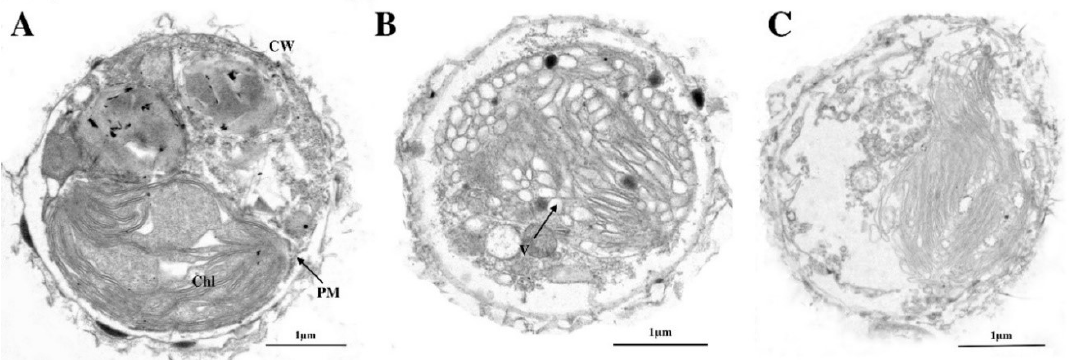
Figure 2. Ultrastructure of P. globosa after treatment with 8 g/L of E. acoroides aqueous extract. ( A ) Control, ( B ) 48 h, ( C ) 96 h. Chl, chloroplast; PM, plasma membrane; V, vacuole; CW, cell wall.